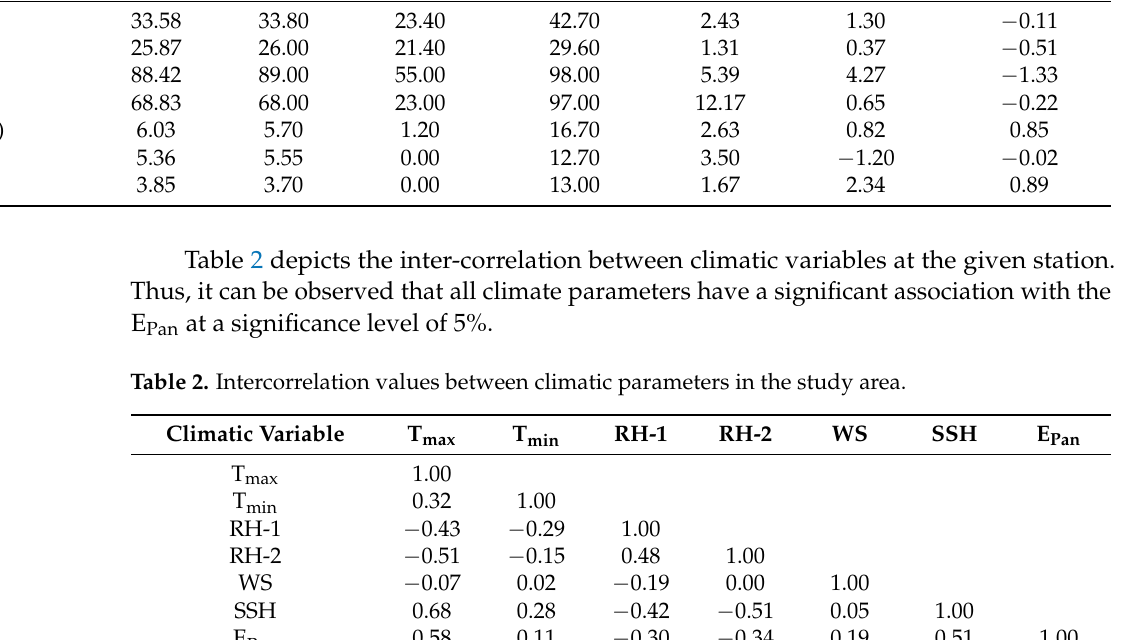
Table 1. Statistical constraints of climatic parameters from 2013 to 2017 in the study area. Statistical Parameters Mean Median Minimum Maximum Std. Dev.